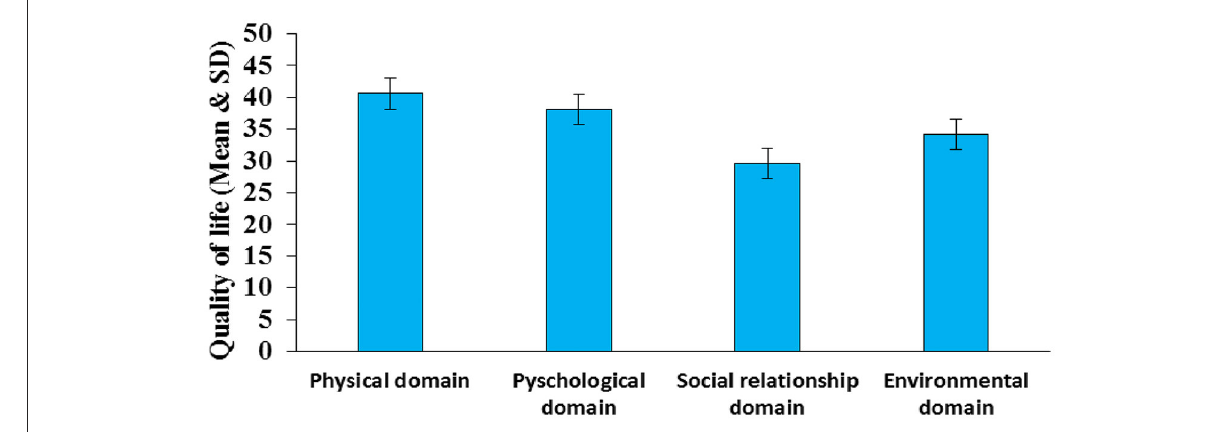
FIGURE2 Mean scores of quality of life domains among women with obstetric